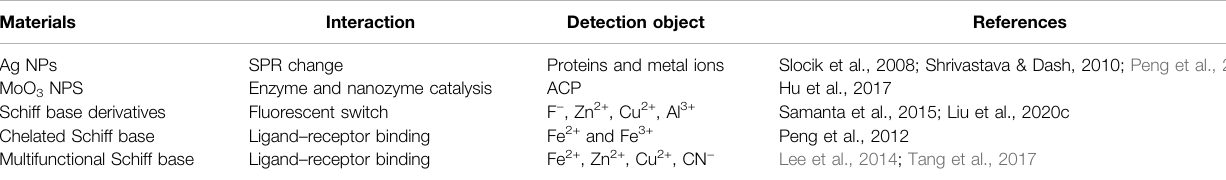
TABLE 6 | Selected examples of different 2D nanomaterials as colorimetric